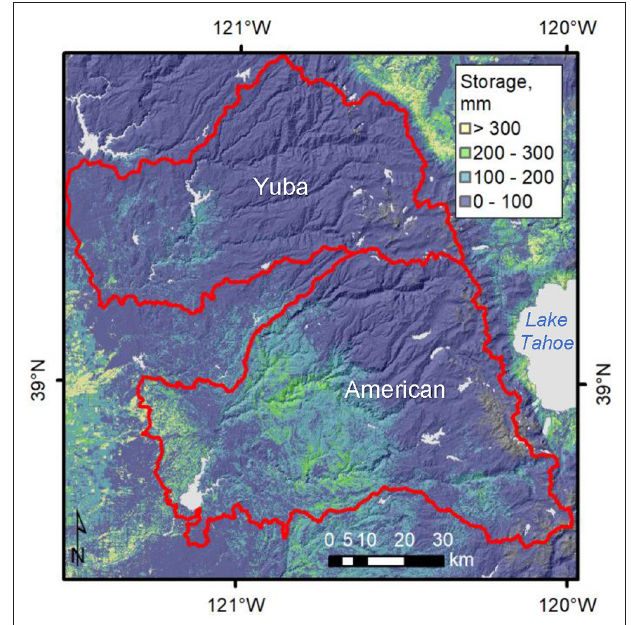
FIGURE 8 | Maximum seasonal amount of subsurface water storage used for evapotranspiration in a single year for the period 1985–2018. Gray area is no data.